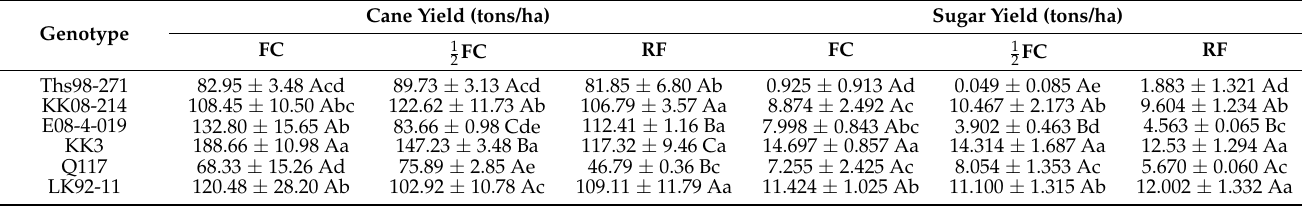
Table 13. Cane yield and sugar yield of six sugarcane genotypes grown under well-watered (FC) and water-stressed ( 1 and RF) conditions.